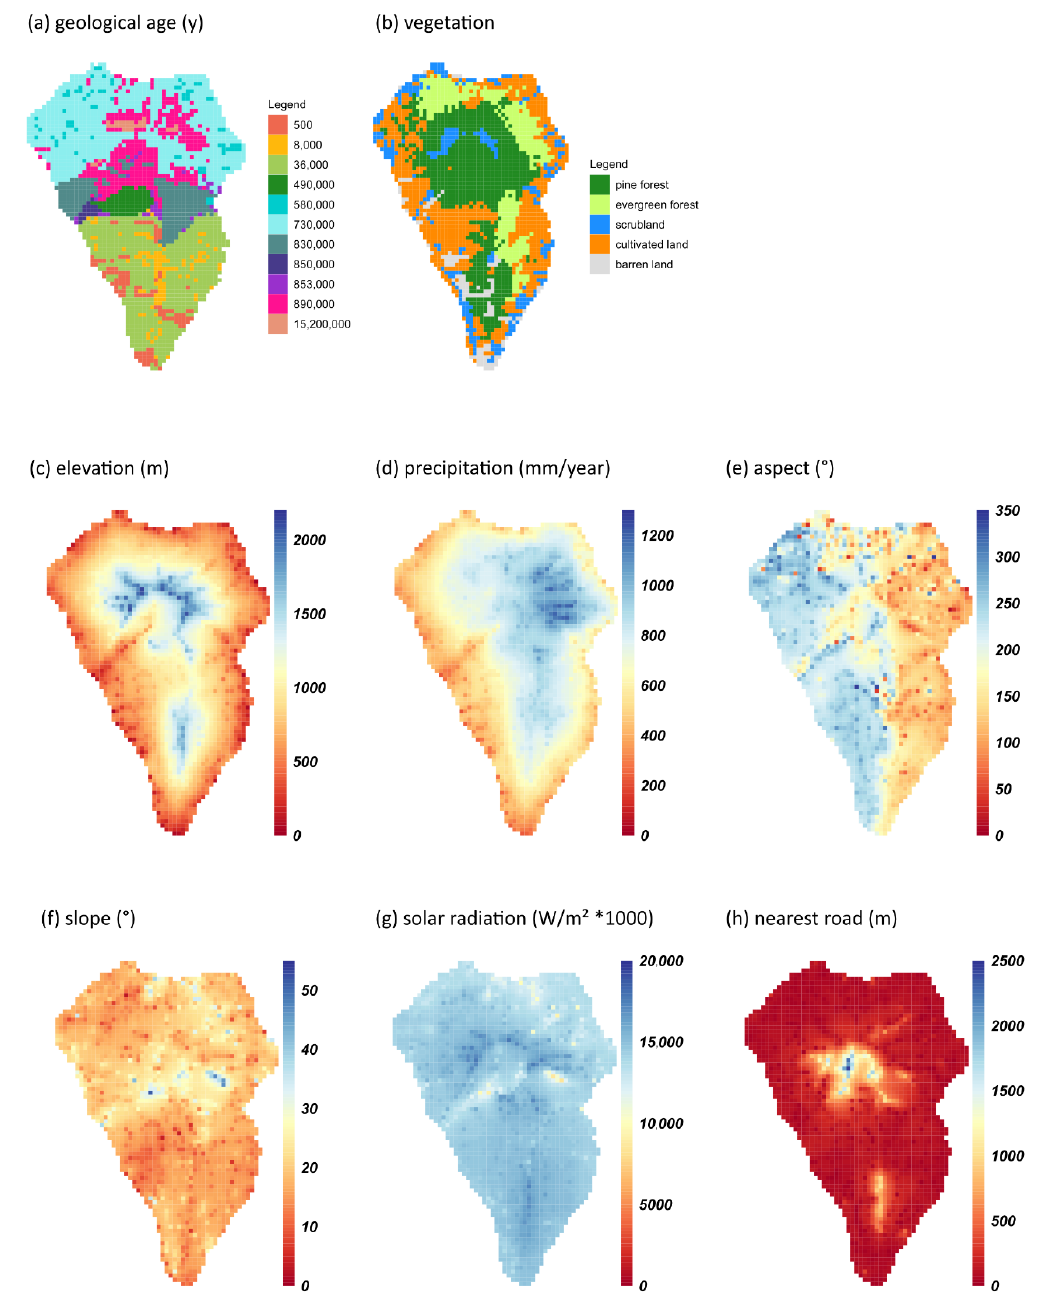
Figure A1. Environmental variables used for building the ensemble model for P. setaceum on La Palma: geological age ( a ), vegetation ( b ), elevation ( c ), mean annual precipitation ( d ), aspect ( e ), slope ( f ), solar radiation ( g ), and the distance to the nearest road ( h ).